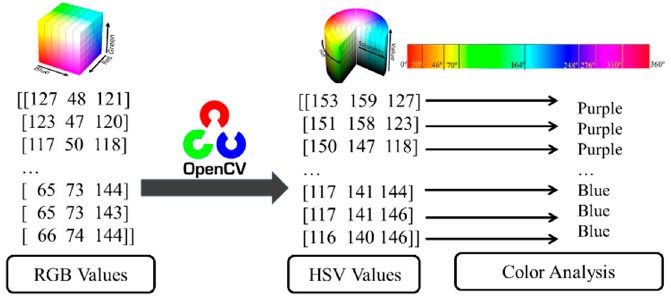
Figure 3. Color recognition flowchart.